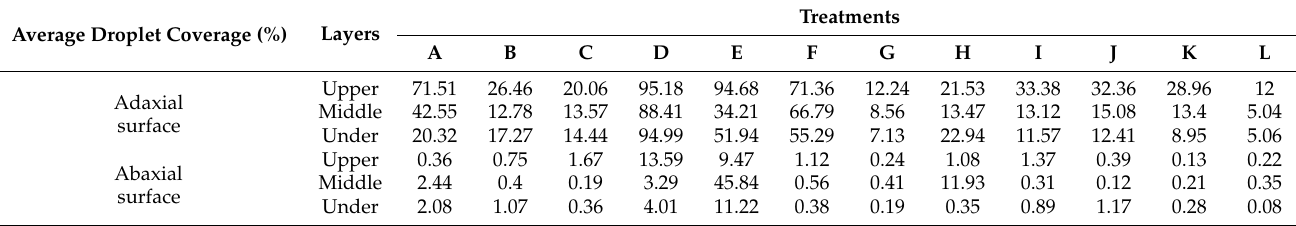
Table 4. Average droplet coverage under different